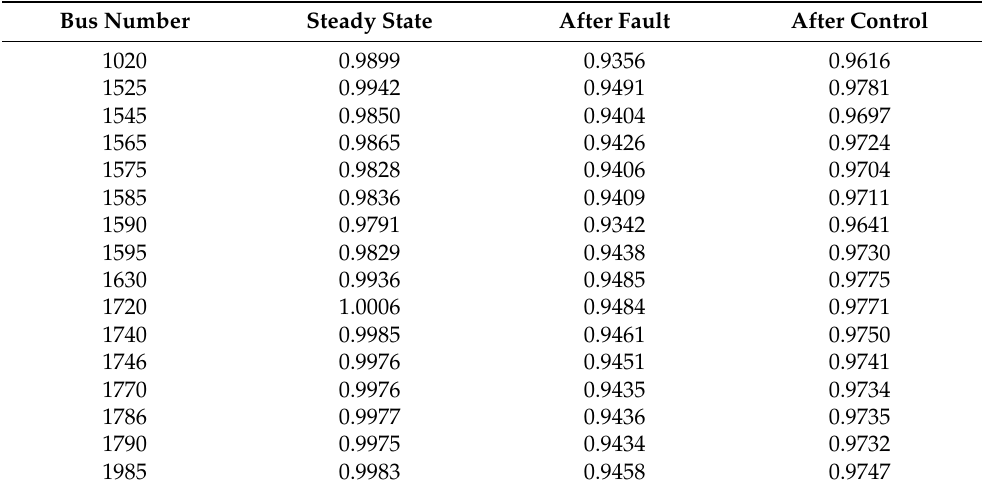
Table 2. Bus voltages of the pre-fault steady state, after fault state, and after fault with control. Bus Number